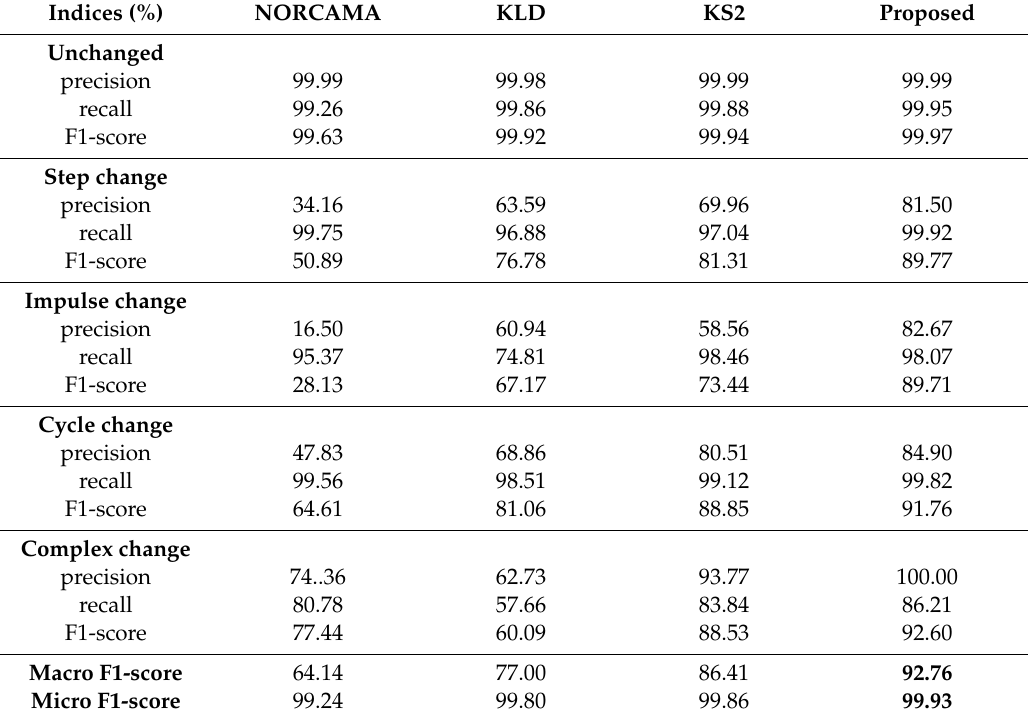
Table 4. Quantitative comparison of change classification accuracy for di ff erent methods using synthetic